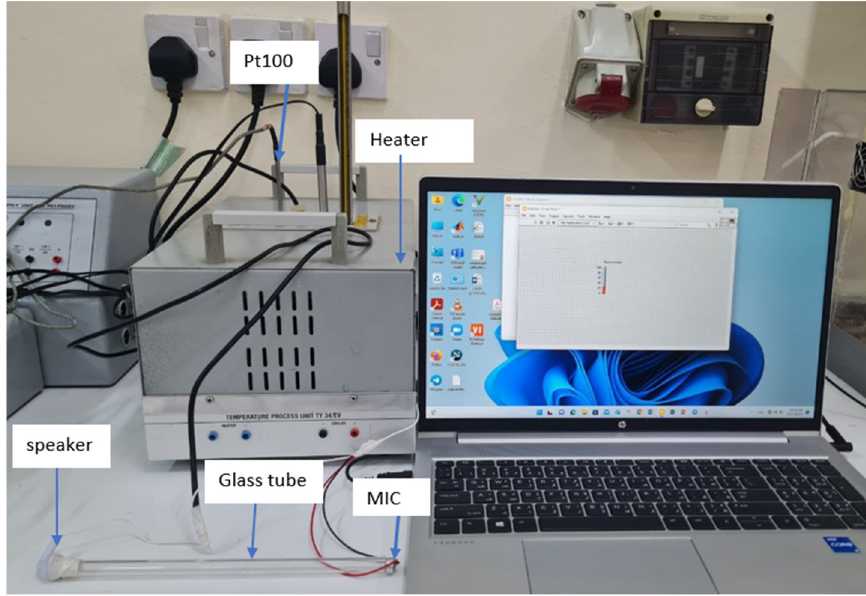
Figure 6 . The experimental setup. Figure 6. The experimental setup.